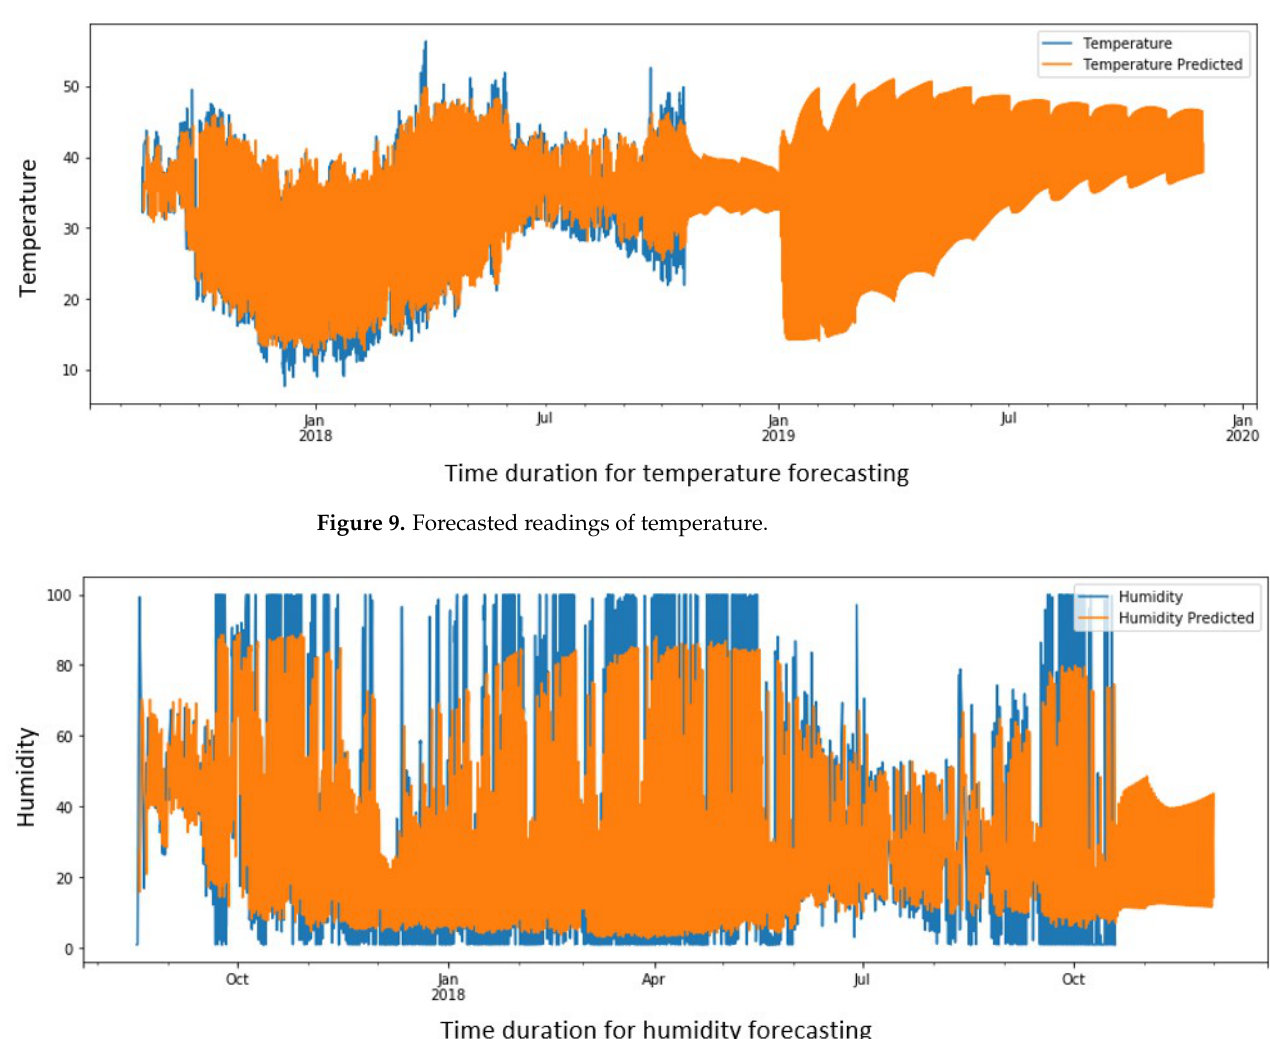
Figure 10. Forecasted readings of humidity.